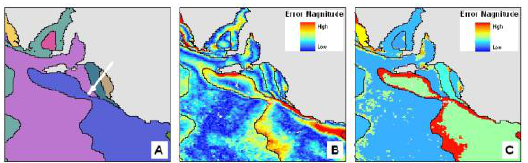
Figure Five: Local example showing A – Classes; B – Standardized region pixel deviation magnitude; and C – pixel deviation